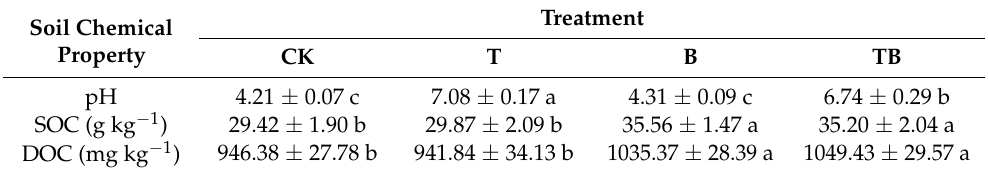
Table 1. A comparison of the various soil chemical properties (mean ± SE) among the different treatments, including the control (CK), oyster shell powder (T), biochar (B), and a combined amendment (TB). Soil